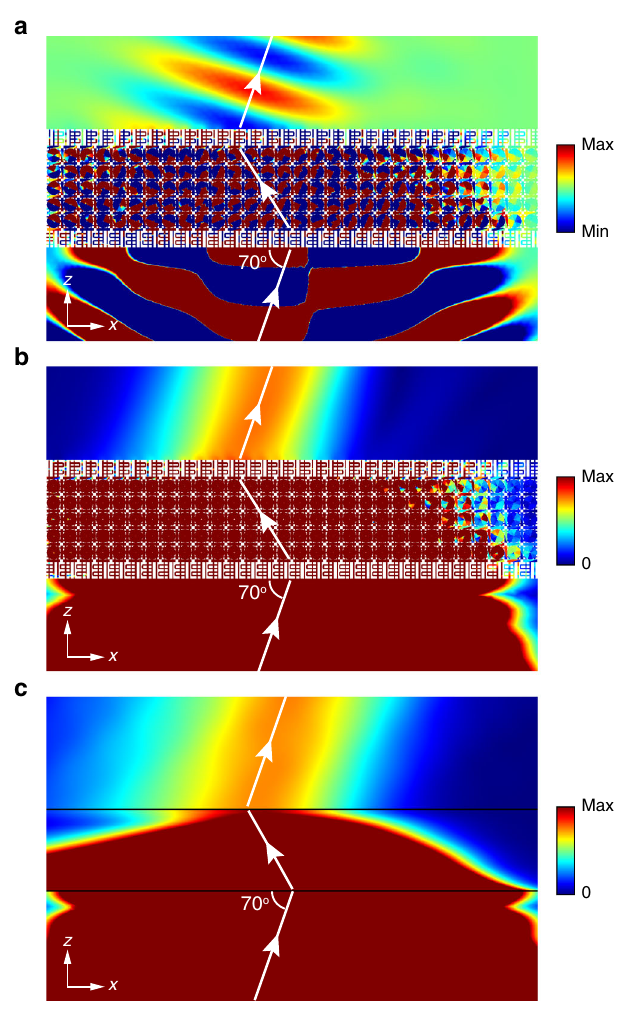
Fig. 4 Negative refraction induced by SOI in momentum space. The real part ( a ) and the amplitude ( b ) of the pressure fi eld for a Gaussian beam that propagates through the acoustic metamaterial with an incident angle of 70°. c The amplitude of pressure fi eld in the corresponding micropolar effective medium